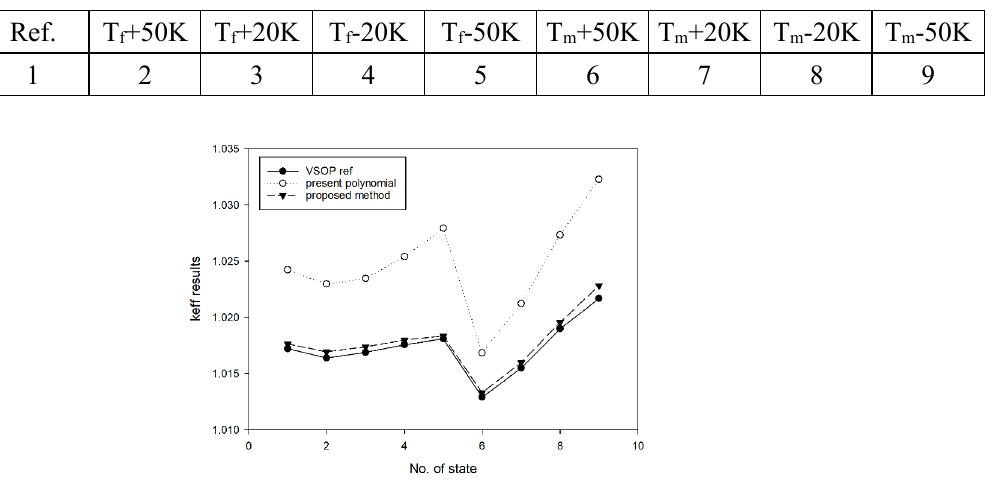
Table II. List of comparison states.